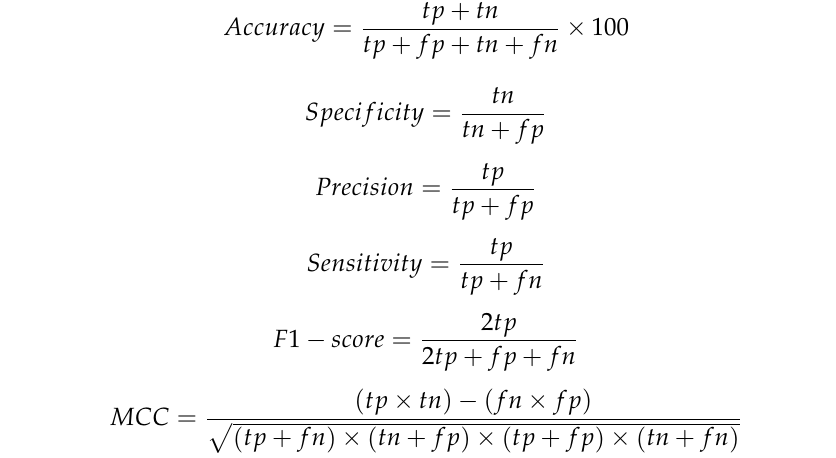
Figure 11. Confusion matrices obtained as a result of classification of selected features with SVM.